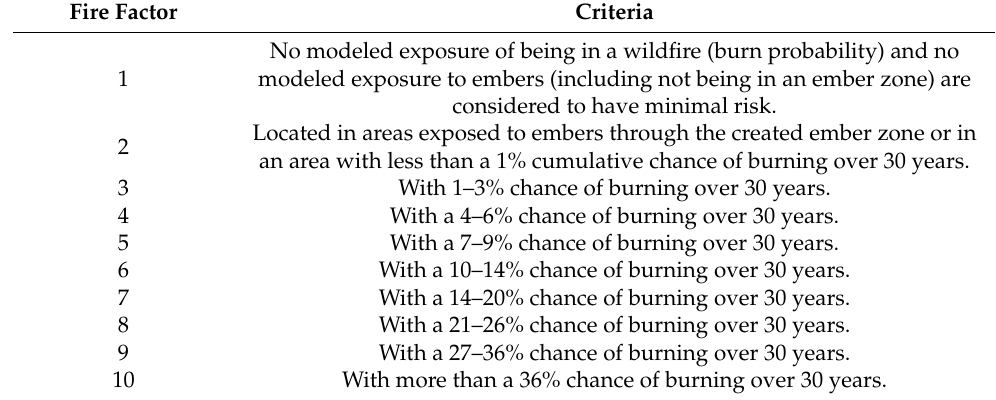
Table 5. Fire factor